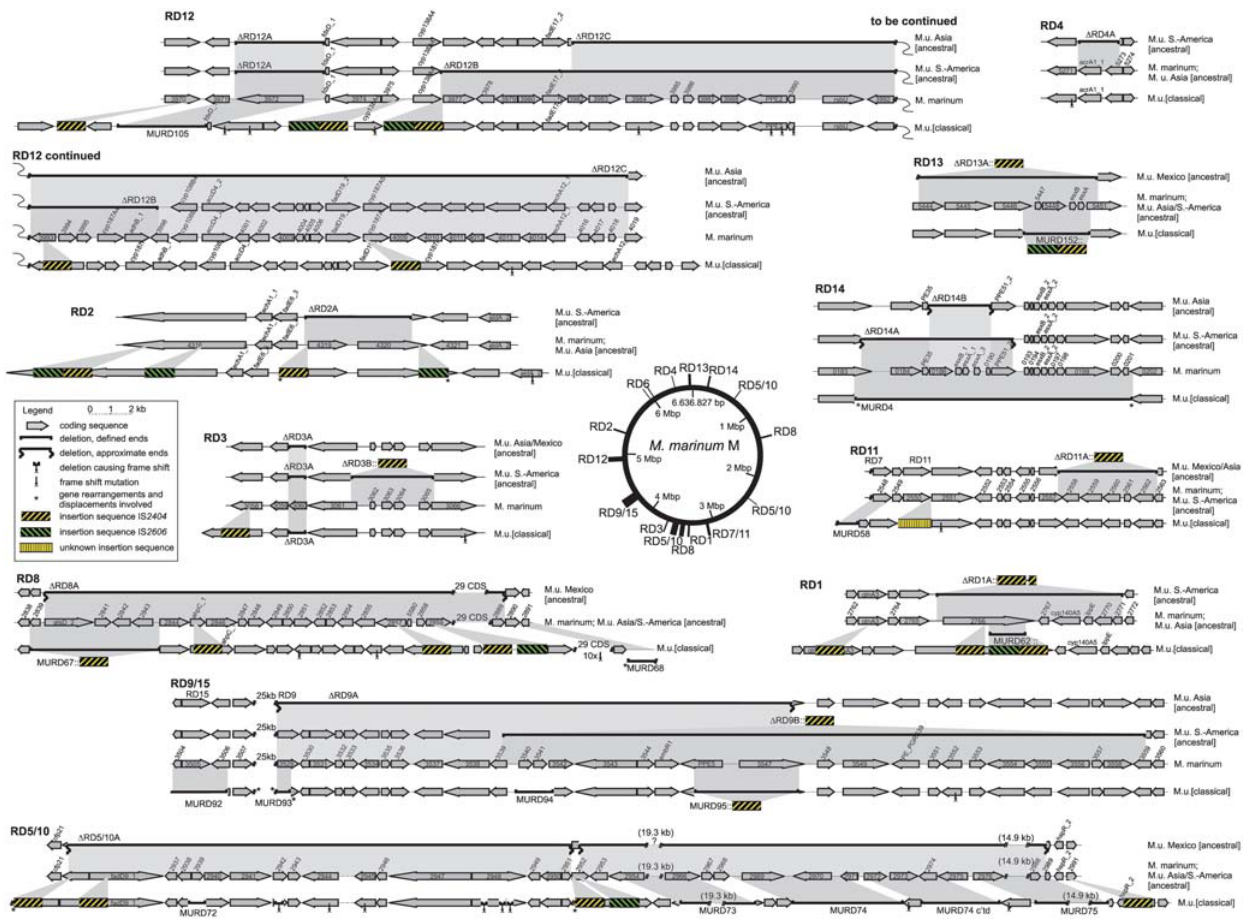
Figure 2. Description of RDs1-15 throughout the M.ulcerans haplotypes. Shown are the CDSs of the M. marinum M sequence backbone (which is closest to the entirety of all M. ulcerans haplotypes and thus to an M. ulcerans most recent common ancestor). Variations thereof in M. ulcerans haplotypes are depicted above the M. marinum sequence for members of the ancestral lineage, as indicated, and below for the classical lineage (exemplified by Agy99). Grey areas indicate differences of insertions, deletions, or InDels, as compared to M. marinum . Nomenclature of CDSs is indicated along the M. marinum annotation [40], i.e. 3970 stands for MMAR_3970. Symbol explanations see legend. Note that some genomic loci of Agy99 can neither be aligned directly to M. marinum M nor to M. ulcerans ancestral haplotypes due to major sequence rearrangements and displacements in the classical lineage only (indicated with *). Pseudogenes caused by frame shift mutations, according to the M. ulcerans Agy99 genome annotation, are marked as ‘‘x’’. Bar=deletion. Blunt ends of bars: breakpoints exactly defined. Blurred ends of bars: breakpoints approximately. MURDs are confined to the M. ulcerans classical lineage but are usually not deleted in the ancestral lineage. Not shown are RDs6 and 7 since they do not reveal deletions relative to M. marinum M. A corresponding and complete list of silenced CDS is supplied in Table